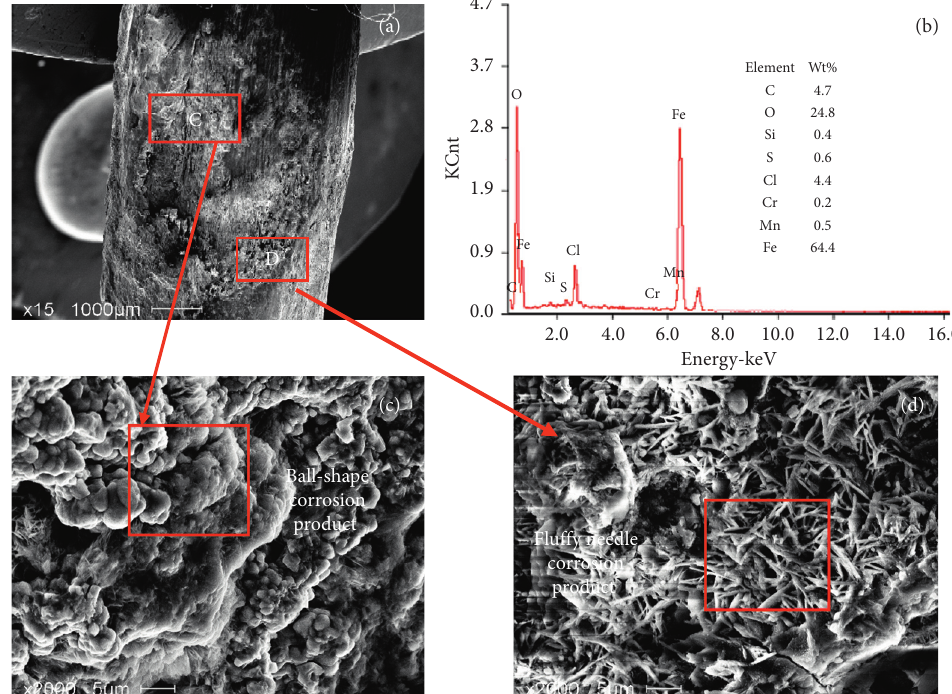
Figure 9: Morphology and EDS analysis of surface corrosion products near the fracture: (a) with 15 times magnification; (b) EDS analysis; (c) point C with 2000 times magnification; (d) point D with 2000 times magnification.